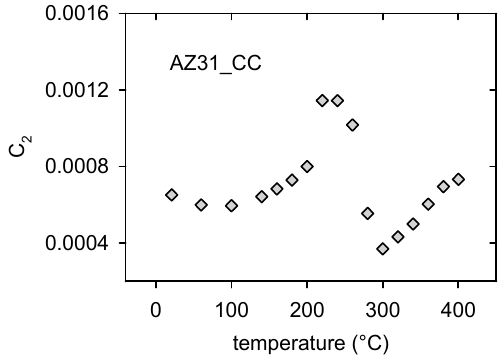
Figure 12. The fitting parameter C 2 vs. the upper temperature of the thermal cycle.